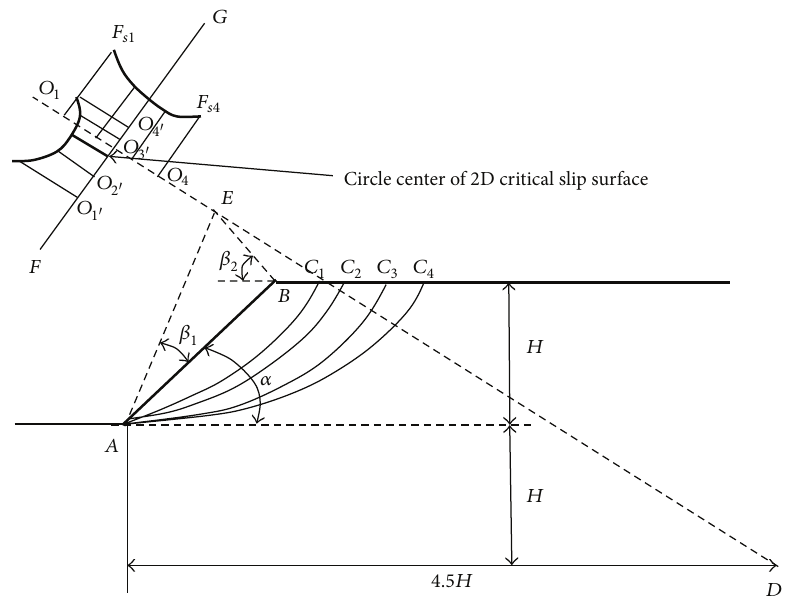
Figure 6: Determination of 2D potential failure surfaces when internal friction angle 𝜑 > 0 [20].